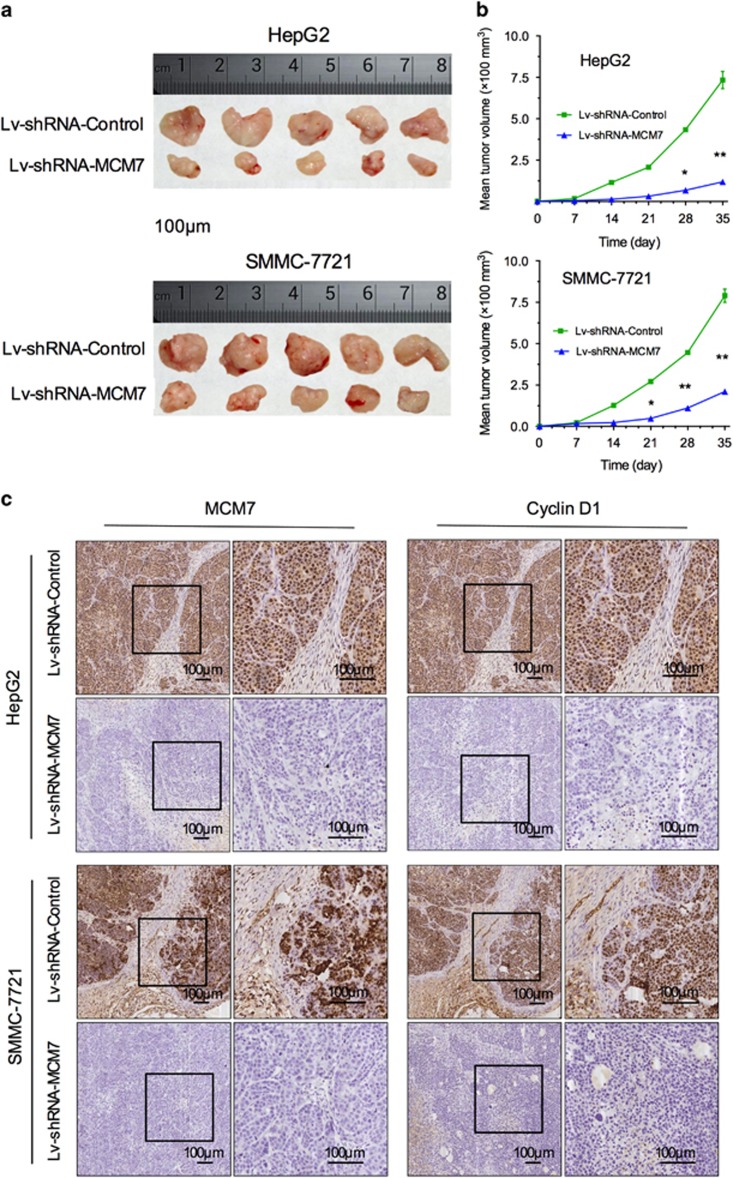
Knockdown of MCM7 inhibited tumor growth in vivo. (a) Tumor nodules after subcutaneously inoculation of HCC cells transfected with Lv-shRNA-MCM7 or Lv-shRNA-Control for 4 weeks (n=5 for each group). (b) Xenograft tumor volume of different groups bearing HCC cells transfected with Lv-shRNA-MCM7 or Lv-shRNA-Control. (c) Representative IHC staining of MCM7 and Cyclin D1 in xenograft tumors of different groups. Bar=100 μm. *P<0.05, **P<0.01